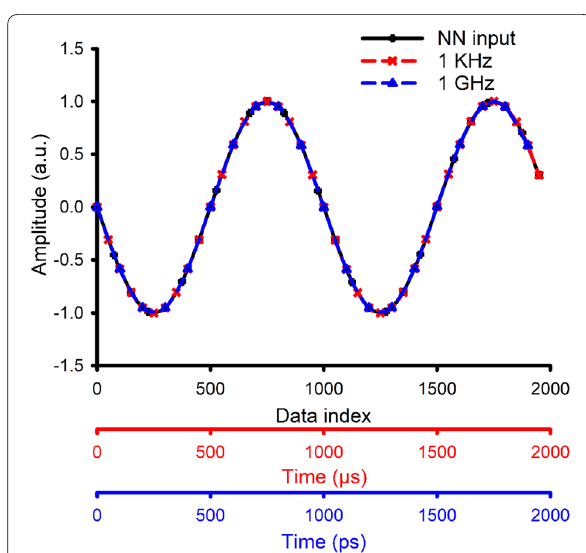
Fig. 4 Generalizing the results to other frequencies. A same wave for NN input (black), 1 kHz (red), and 1 GHz (blue). The NN model cannot see the difference between these input